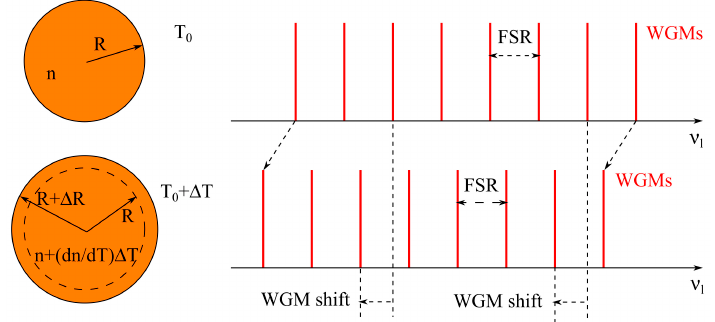
Figure 1. Schematic diagram of the whispering gallery modes (WGMs) for a microsphere at the initial temperature T 0 and heated by Δ T.